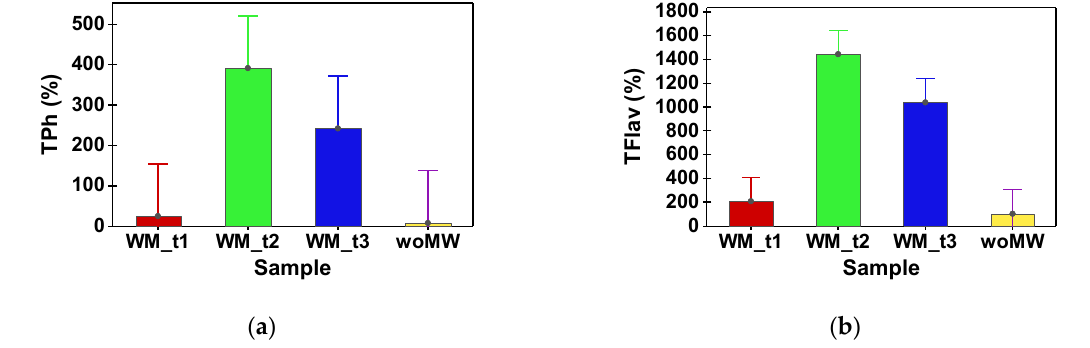
Figure 3. Ratios (%) between peppermint samples (MW_t1, MW_t2, and MW_t3) and the untreated sample, woMW. ( a ) Total polyphenols (TPh). ( b ) Total flavonoids (TFlav).